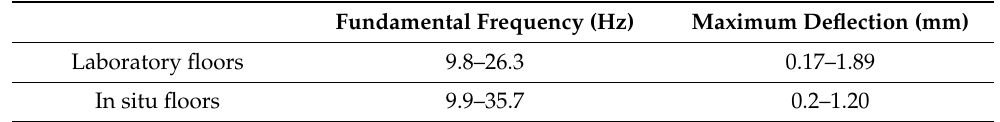
Table 4. The results of the frequency and maximum deflection obtained from the multi-phase study on the vibration performance of cold-formed steel floors prepared by Xu [36].